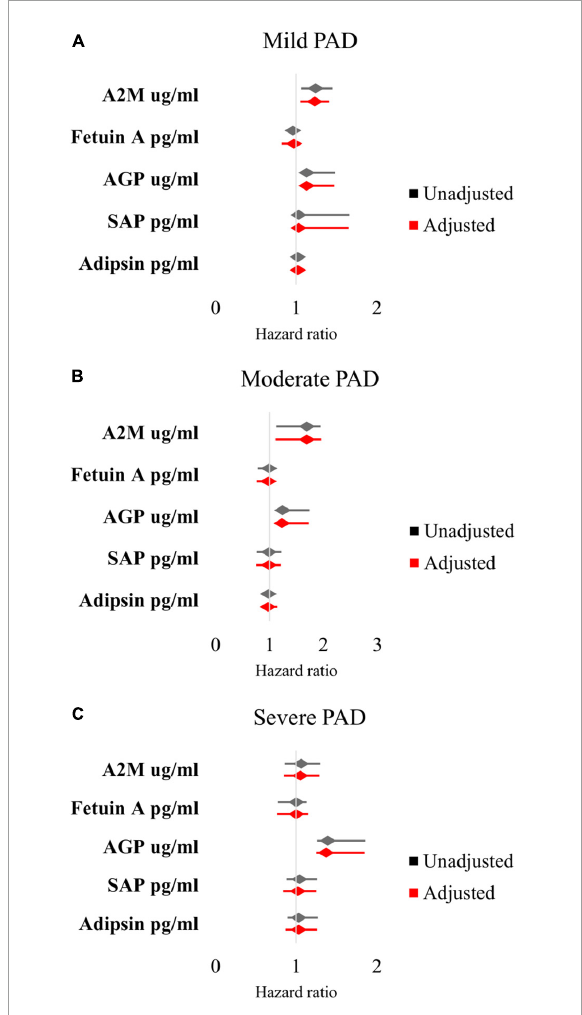
FIGURE1 Multivariable Cox proportional hazards analysis of association between inflammatory protein levels and major adverse limb events in patients with (A) mild PAD, (B) moderate PAD, and (C) severe PAD. Adjusted for baseline demographic and clinical characteristics: age, sex, hypertension, dyslipidemia, diabetes, chronic kidney disease, smoking status, congestive heart failure, and coronary artery disease. PAD, peripheral artery disease.